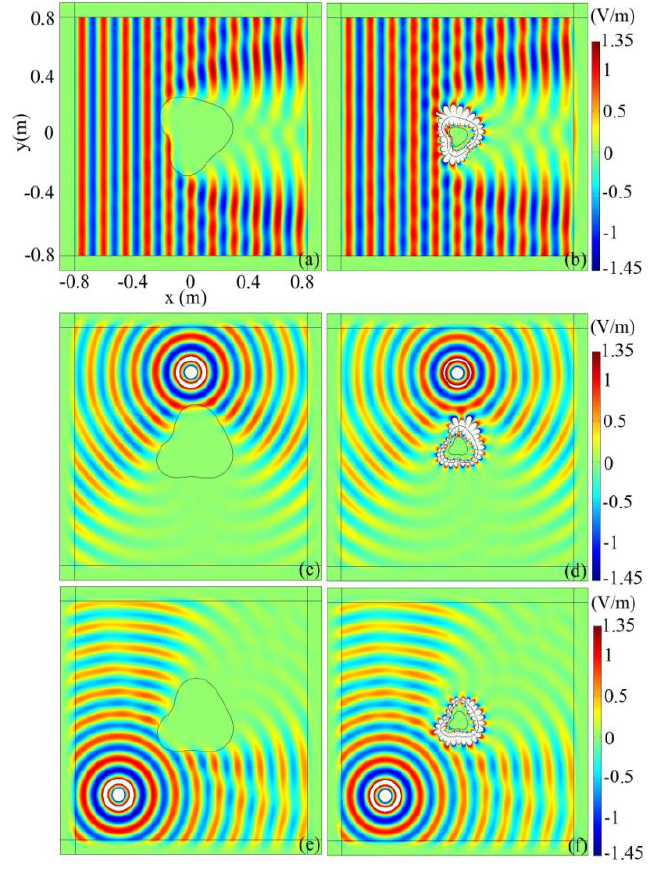
Figure 4. The electric field distribution in the computational domain. (a–b). The TE plane wave is incident from the left and the object is rotated by π /4; (c–d). the line source is located at (0, 0.5 m); (e–f). the line source is located at (−0.5 m, −0.5